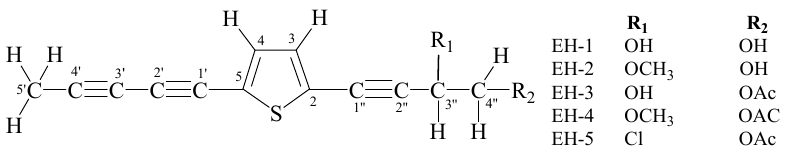
Figure 1. Acetylenicthiophenes from Echinops hoehnelii Schweinf.